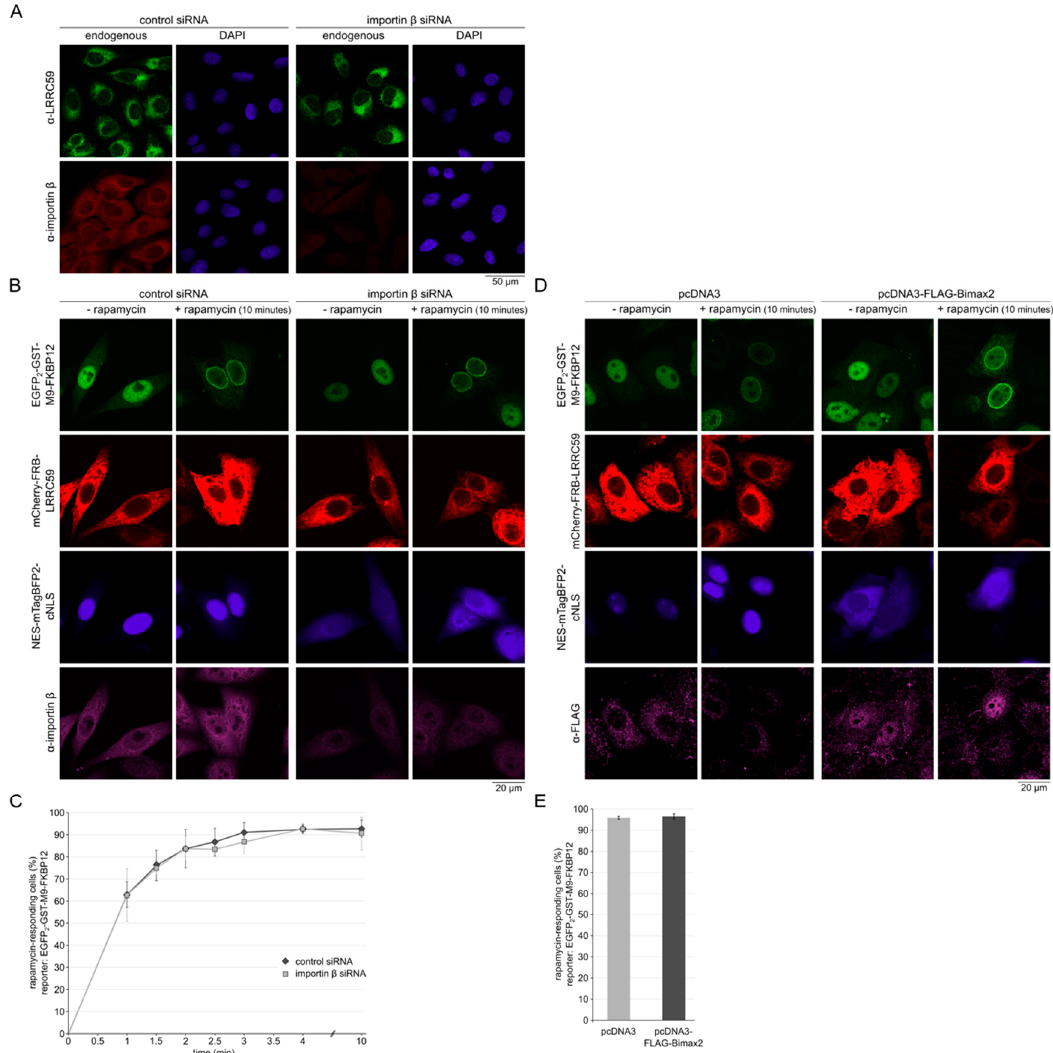
Figure 5. Importin β is not required for INM-targeting of LRRC59. ( A ) U2OS cells were treated with control siRNAs or siRNAs against importin β . After 48 h, cells were subjected to indirect immunofluorescence using antibodies against LRRC59 or, on separate slides, importin β . ( B ) HeLa cells were transfected with control siRNAs or siRNAs against importin β and with plasmids coding for EGFP 2 -GST-M9-FKBP12, mCherry-FRB-LRRC59 and NES-mTagBFP2-cNLS. After 48 h, cells were treated with rapamycin at room temperature for 10 min, fixed, immunostained using antibodies against importin β and analyzed by confocal microscopy. ( C ) Quantification of rapamycin assays as in ( B ). The percentage of cells responding to rapamycin with a recruitment of EGFP 2 -GST-M9-FKBP12 to the nuclear periphery was plotted against the time after addition of the drug. Error bars indicate the standard deviation from the mean of five independent experiments, counting 100 (1–4 min) or 250 (10 min) cells per time point. ( D ) HeLa cells were co-transfected with plasmids coding for EGFP 2 -GST-M9-FKBP12, mCherry-FRB-LRRC59, NES-mTagBFP2-cNLS and FLAG-Bimax2 or pcDNA3 as a control, respectively. After 48 h, cells were treated with rapamycin for 10 min, fixed, immunostained using antibodies against the FLAG-tag and analyzed by confocal microscopy. ( E ) Quantification of rapamycin assays as in ( D ), plotting the percentage of cells responding to rapamycin with a recruitment of the reporter protein to the nuclear periphery. Error bars indicate the standard deviation from the mean of 3 independent experiments, counting 200 cells each.